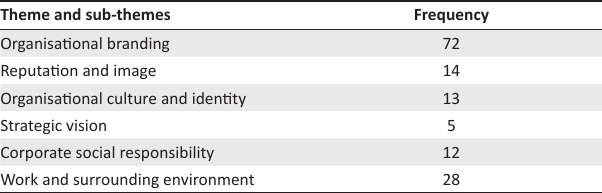
TABLE 2: Frequency of themes. Theme and sub-themes